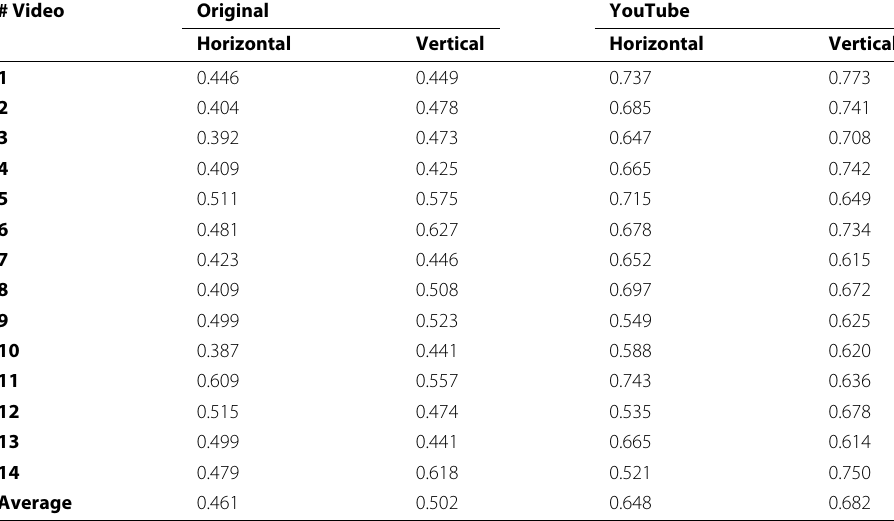
Table 3 Results of homogeneity for video